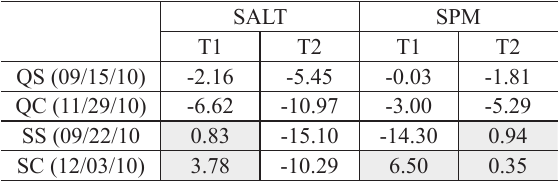
Salt residual lows (Kg/ms), SPM (g/ ms) for T1 and T2. Positive values indicate flow toward the ocean (values